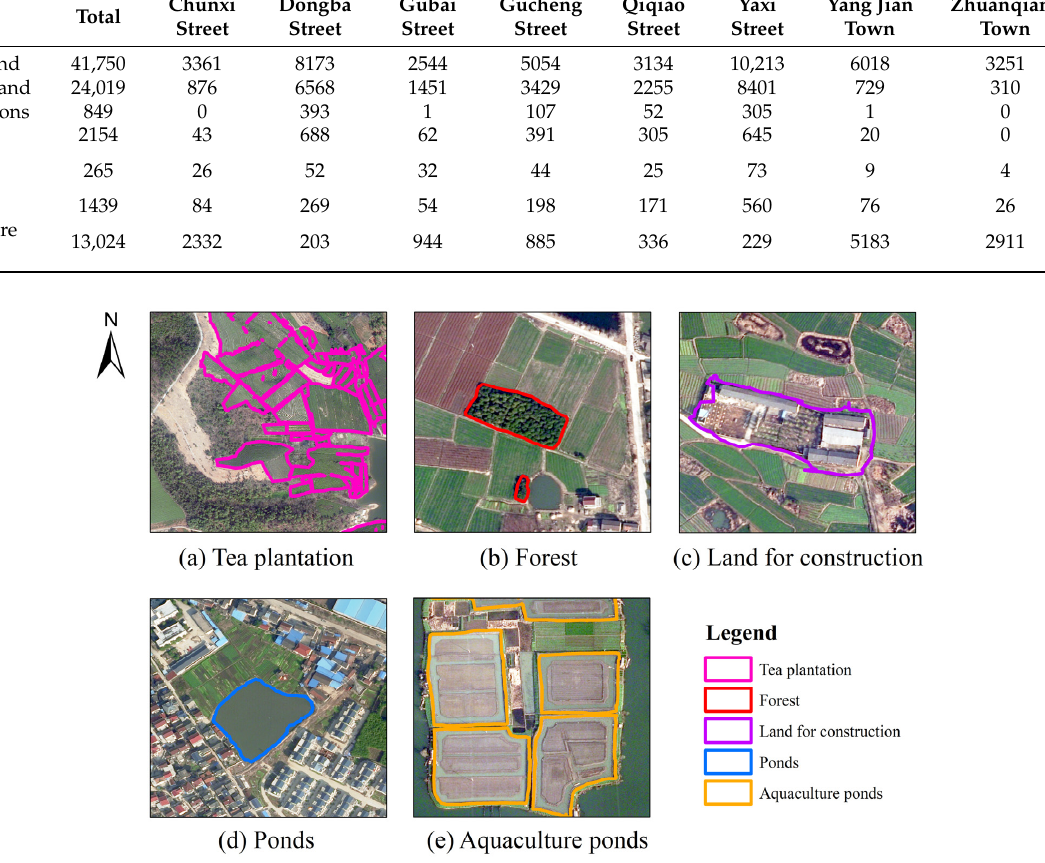
Figure 5. Interpretation results.